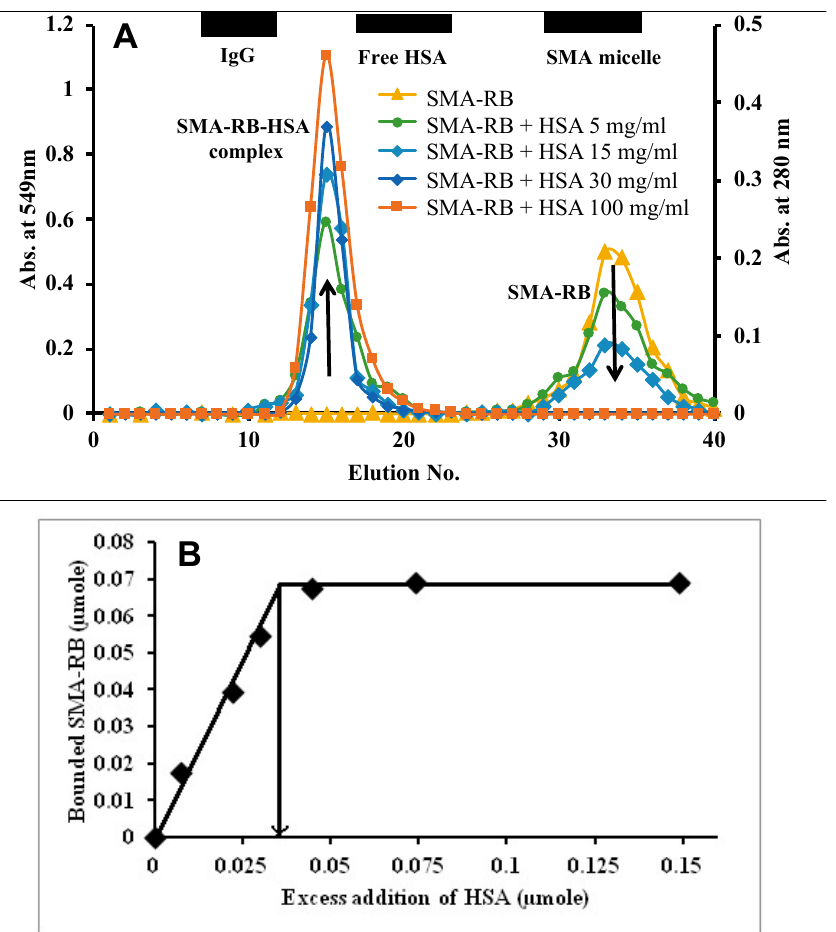
Figure 3. Size exclusion chromatography of SMA-RB in the presence and absence of Human serum albumin (HSA). ( A ) Gel chromatography of SMA-RB with/without HSA was performed using a Sephacryl S200 column (size: 1.5 cm Ø × 48 cm (L)) with the mobile phase of 0.2 M sodium phosphate buffer (pH 7.4). ( B ) HSA concentration vs. % bound SMA-RB curve for calculating the average amount of SMA-RB binding to HSA.